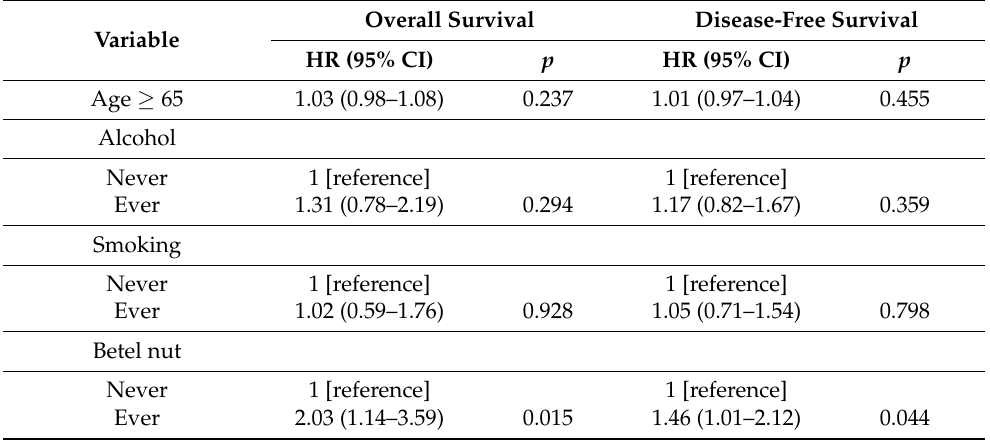
Table 4. Univariate analysis of prognostic factors of overall survival and disease-free survival using Cox regression